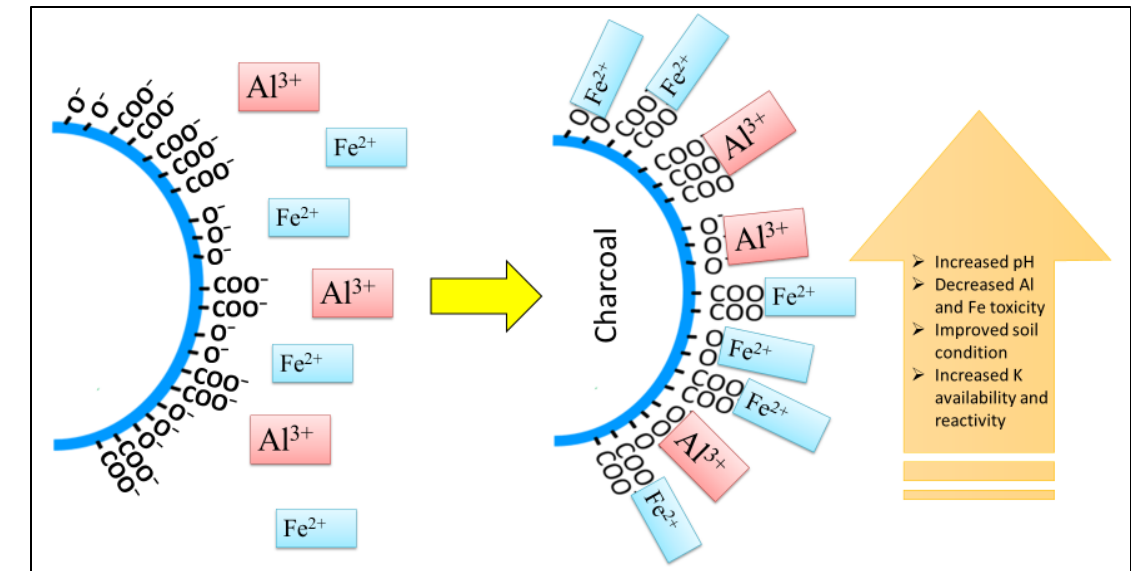
Figure 5. Proposed mechanism of aluminium and iron chelation reactions at the negatively charged exchange sites of soil amendments (adapted from Brady and Weil [31]).